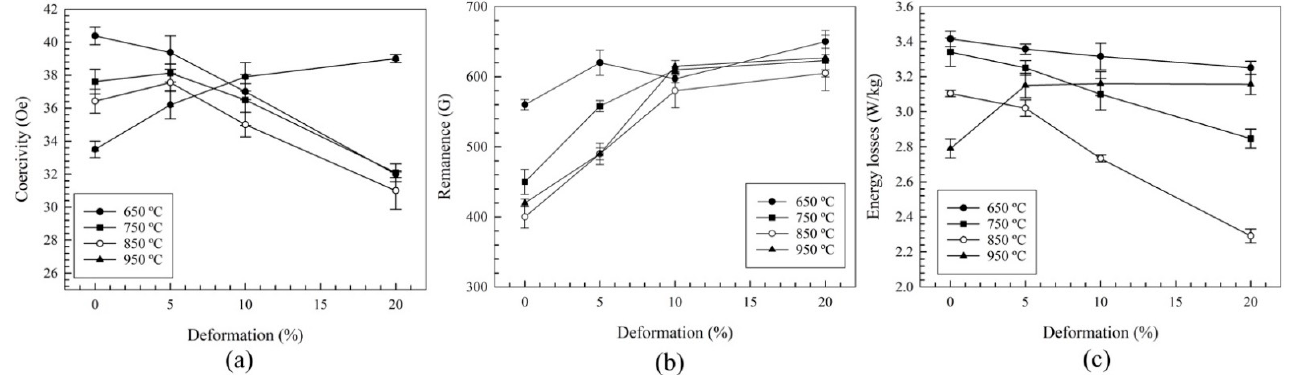
Figure 5. Effect of temperature on the recovery of energy losses in samples deformed at different percentages of reduction and annealed at different temperatures. ( a ) coercivity, ( b ) remanence, ( c ) energy losses.